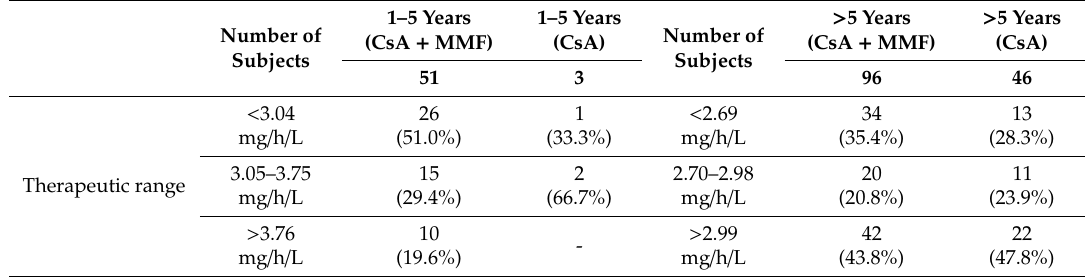
Table 8. Comparative table of CsA AUC exposure values compliances within therapeutic